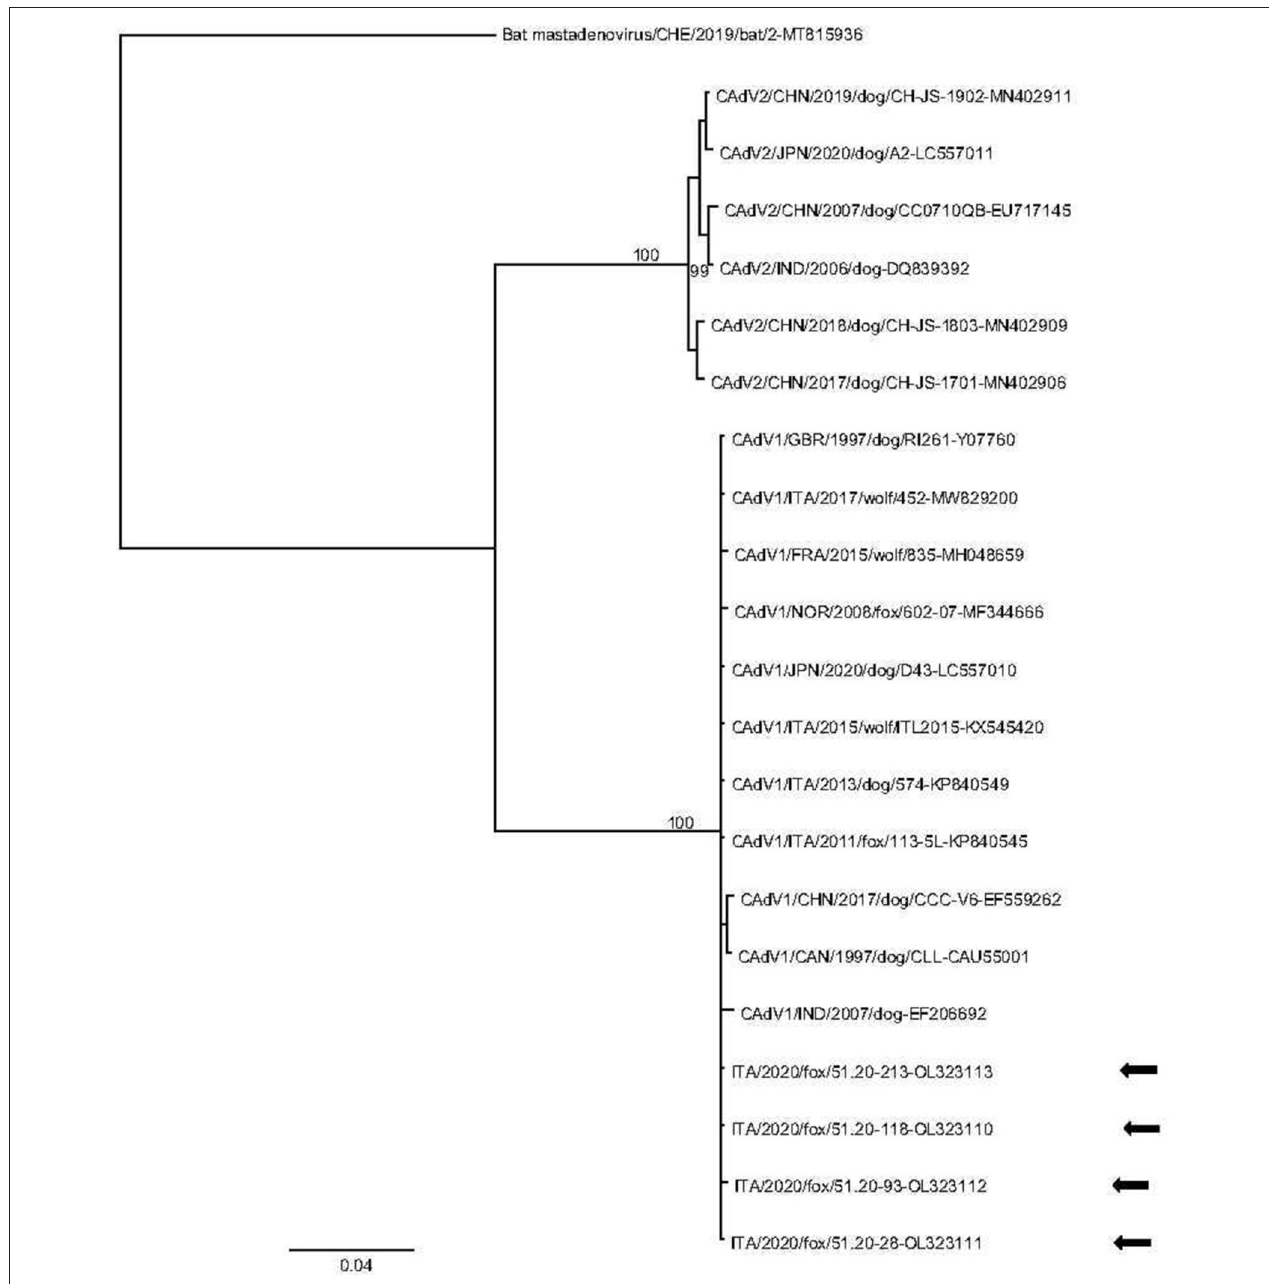
FIGURE 1 | Phylogenetic tree based on alignment of the partial (848 nt) hexon gene of canine adenovirus (CAdV) sequences identified in this study and retrieved from the GenBank database. Bat mastadnovirus (GenBank accession no. MT815936) was used as outgroup. Posterior output of the tree was derived from Bayesian inference using 4 chains run for > 1 million generations, 2-character states (Hasegawa–Kishino–Yano) model, a proportion of invariable sites and a subsampling frequency of 1,000. Posterior probability values > 95 are indicated on the tree nodes. The black arrows indicate the sequences identified in this study. Scale bar indicates nucleotide substitutions per